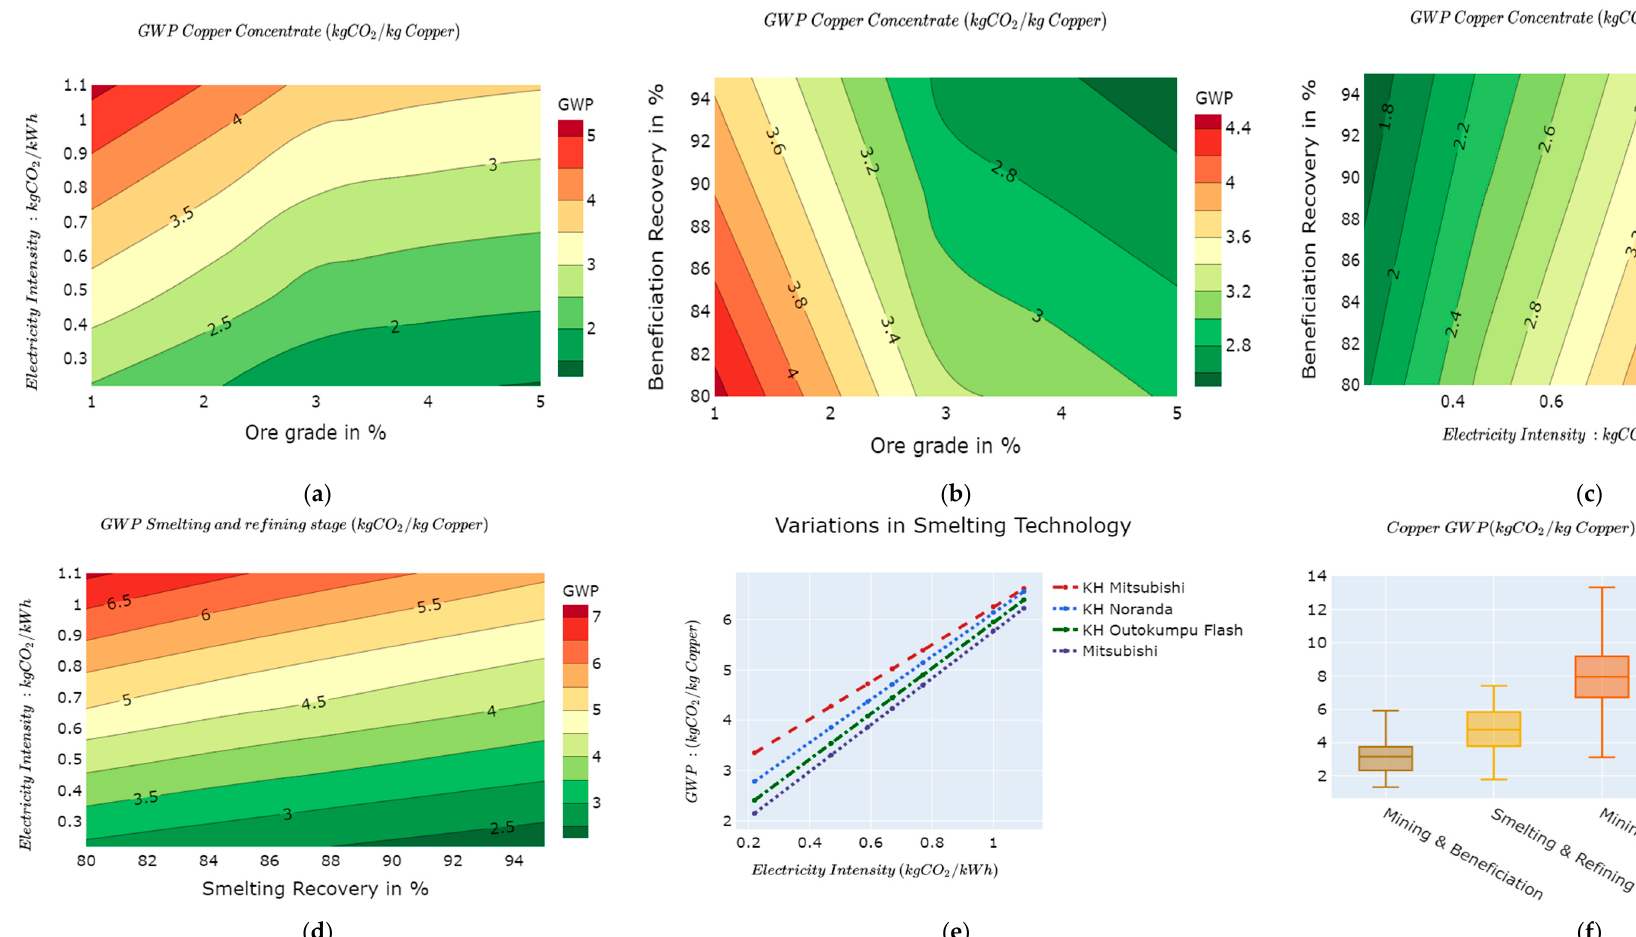
Figure 2. GWP variability along the copper value chain: ( a ) ore grade vs. electricity intensity for mining and beneficiation; ( b ) ore grade vs. beneficiation recovery for mining and beneficiation; ( c ) electricity intensity vs. beneficiation recovery for mining and beneficiation; ( d ) smelting recovery vs. electricity intensity for the smelting and refining stages; ( e ) smelting technology vs. electricity intensity for the smelting and refining stages; and ( f ) overall GWP variations along the copper value chain.